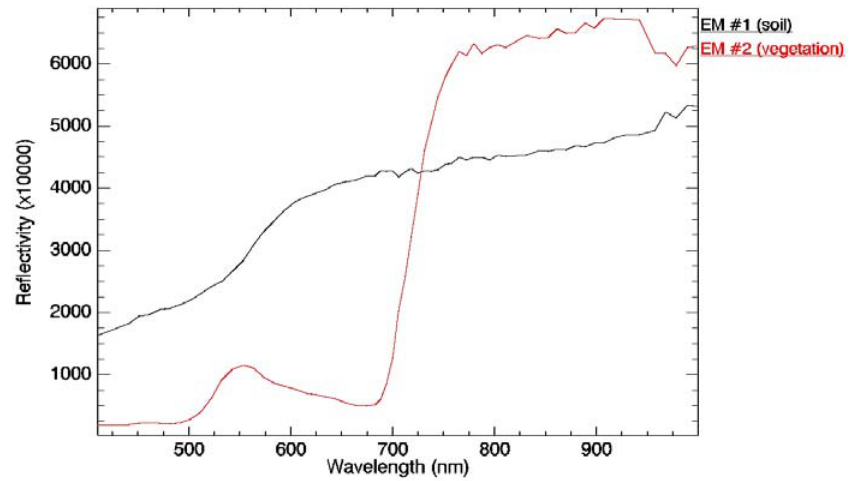
Figure 12. Reflectivity spectra for the endmembers extracted from the image using a land use map over a vegetation pixel and a bare soil